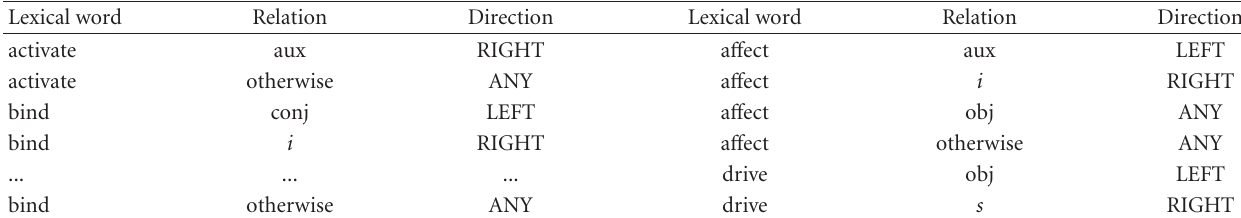
Table 2: Examples of direction rules learned through the third phase (based on MINIPAR).